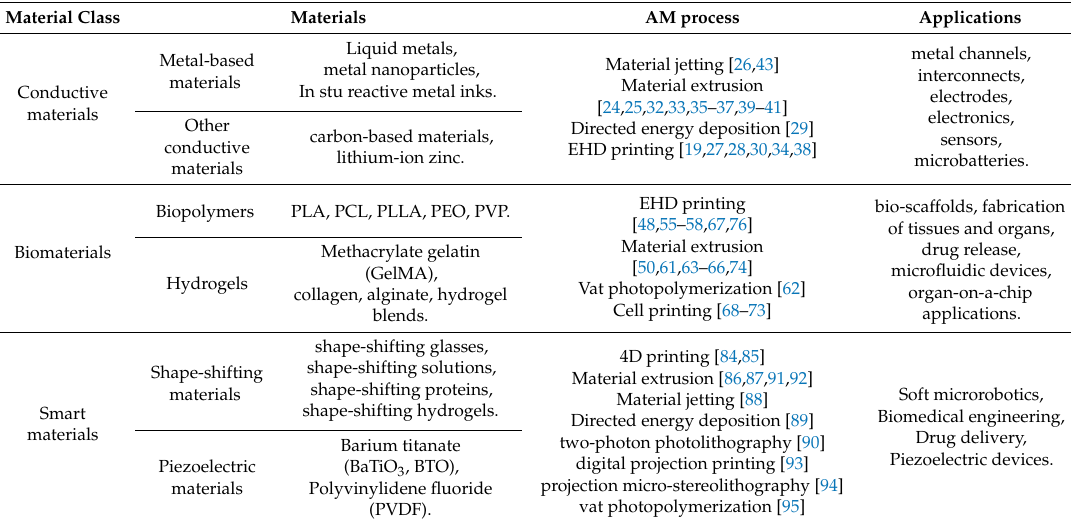
Table 1. Summary of advanced material strategies for additive